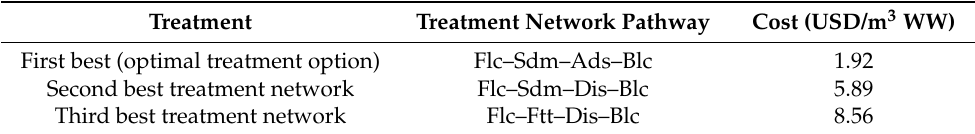
Table 4. The second and third best treatment options for municipal WWT.